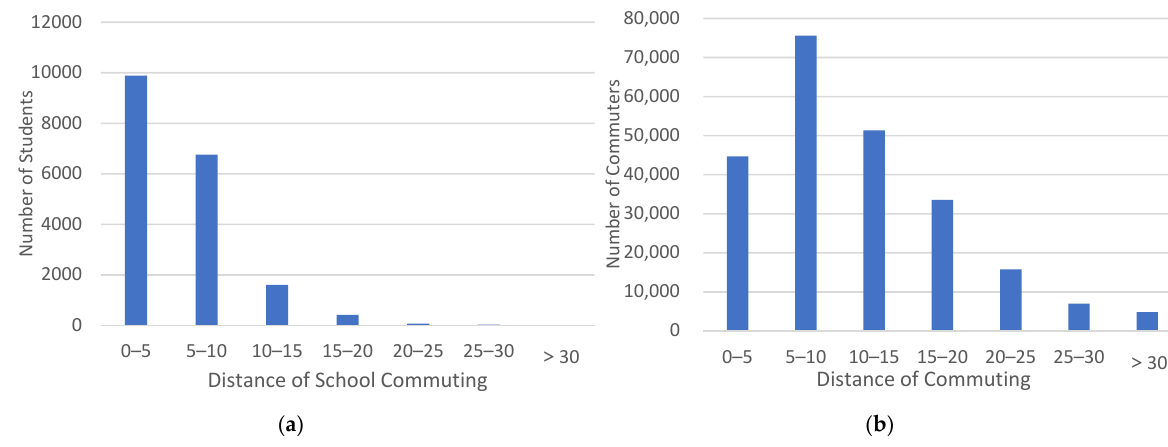
Figure 6. Distribution of students’ and commuters’ distance of commuting. ( a ) Distribution of students’ distance of commuting; ( b ) Distribution of commuters’ distance of commuting.